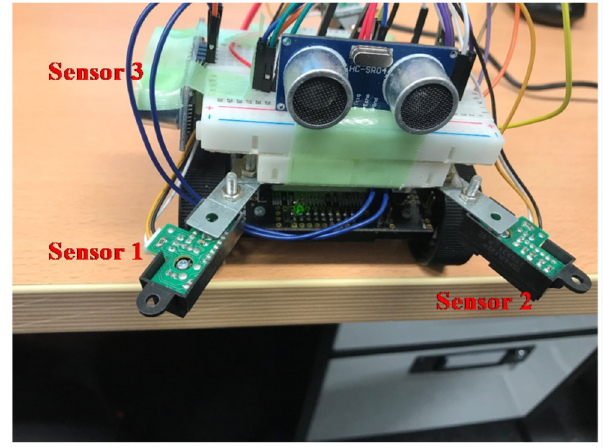
Figure 12. Robot at the time of the sensor output shown in Figure 11.